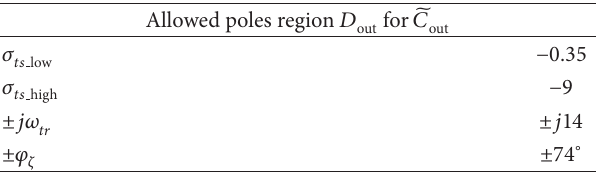
Table 5: Allowed region for optimized internal-loop poles in a complex